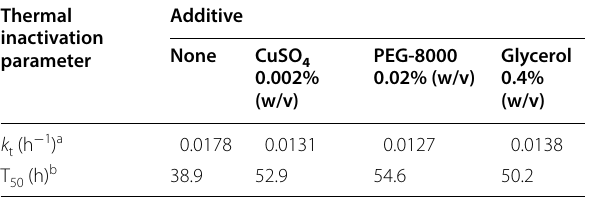
a Constant of inactivation was determined from the first order kinetics behavior of the inactivation effect of increasing incubation time at a specific temperature b T 50 is defined as the incubation time at the specific temperature in acetate buffer (0.1 M, pH 5.0) required to report a 50% decrease in the initial